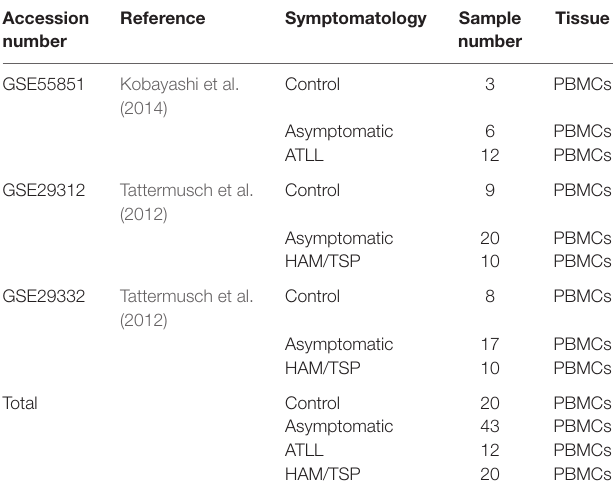
TABLE 1 | Description of the datasets used as the Discovery